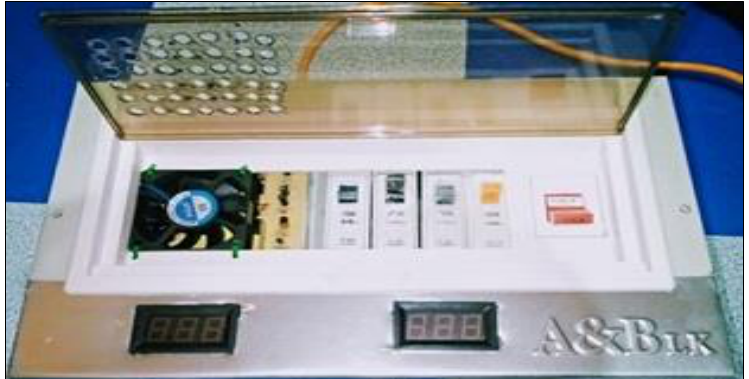
Figure 3: Constructed Hybrid Distribution Board Unpowered.